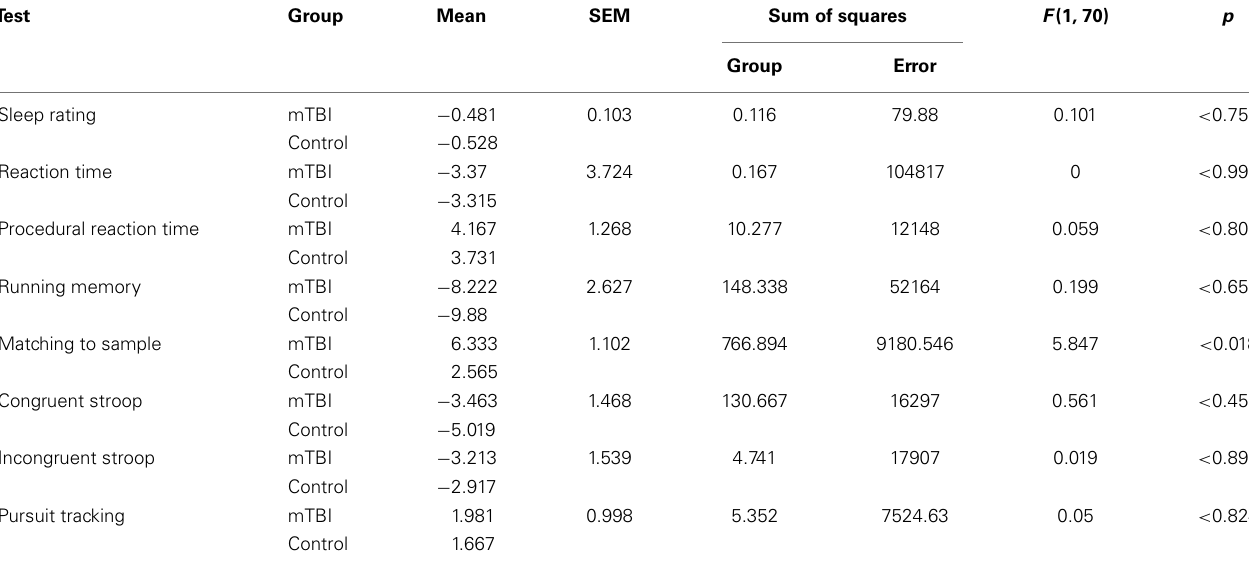
Table 6 | Difference scores for each of the BrainChecker tests for the two groups of subjects and the results of the